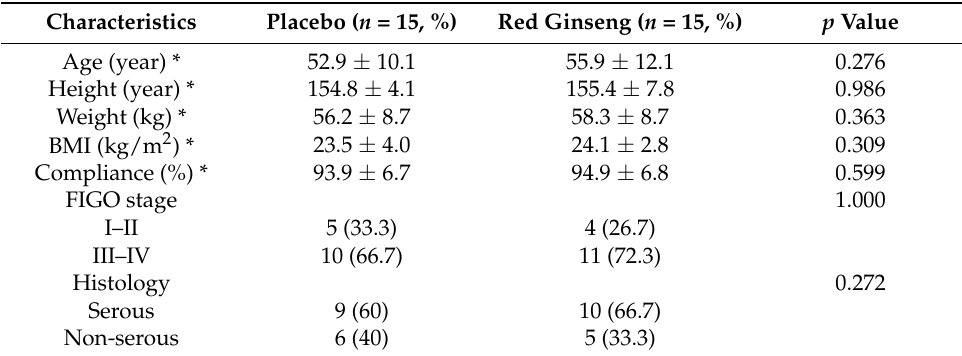
Table 1. Clinico-pathologic characteristics of patients with epithelial ovarian cancer who received placebo or red